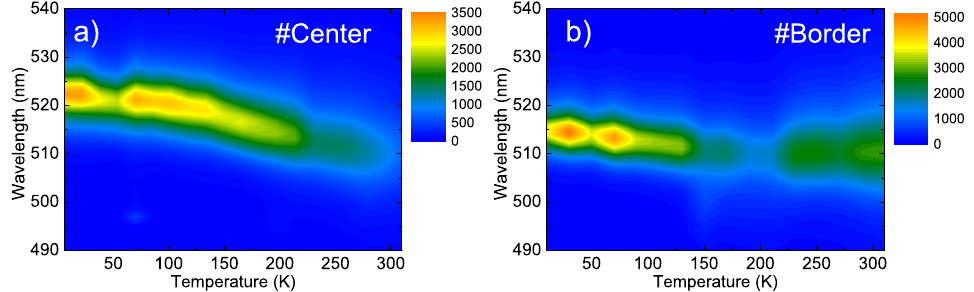
Figure 2. Temperature dependence of the PL spectra at the #Center point ( a ) and at the #Border point in the temperature ranges of 10–190 K ( b ) and 190–310 K ( c ). All of the spectra were vertically translated for clarity. The arrows show the direction of increasing temperature. ( d ): Comparison of the line shapes of the PL spectra at the two investigated points at low and room temperature. The spectra were normalized to 1 at the peak value.